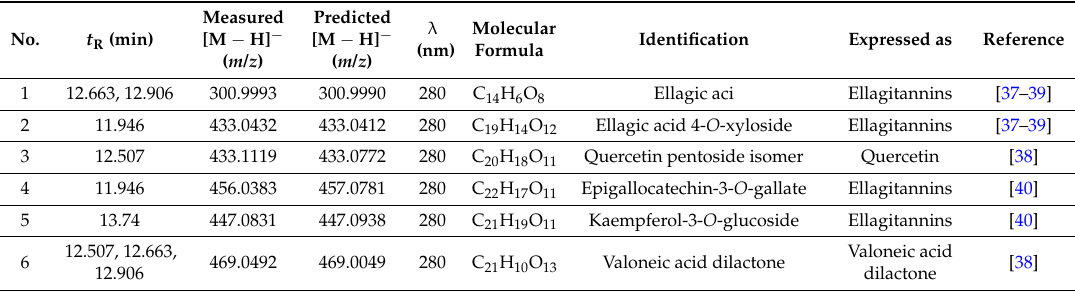
Table 1. Identification of phenolic compounds in WPE using HPLC-ESI-IT-TOF-MS in the negative ion